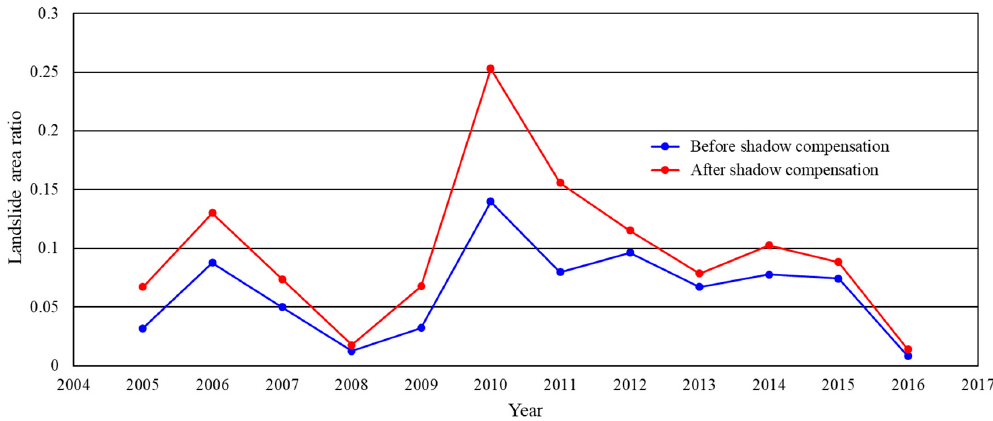
Figure 5. An example of shadow compensation in the watershed of a potential debris flow torrent Tainan DF045. The landslide area ratio time series calculated before and after the shadow compensation are denoted as blue and red lines, respectively.